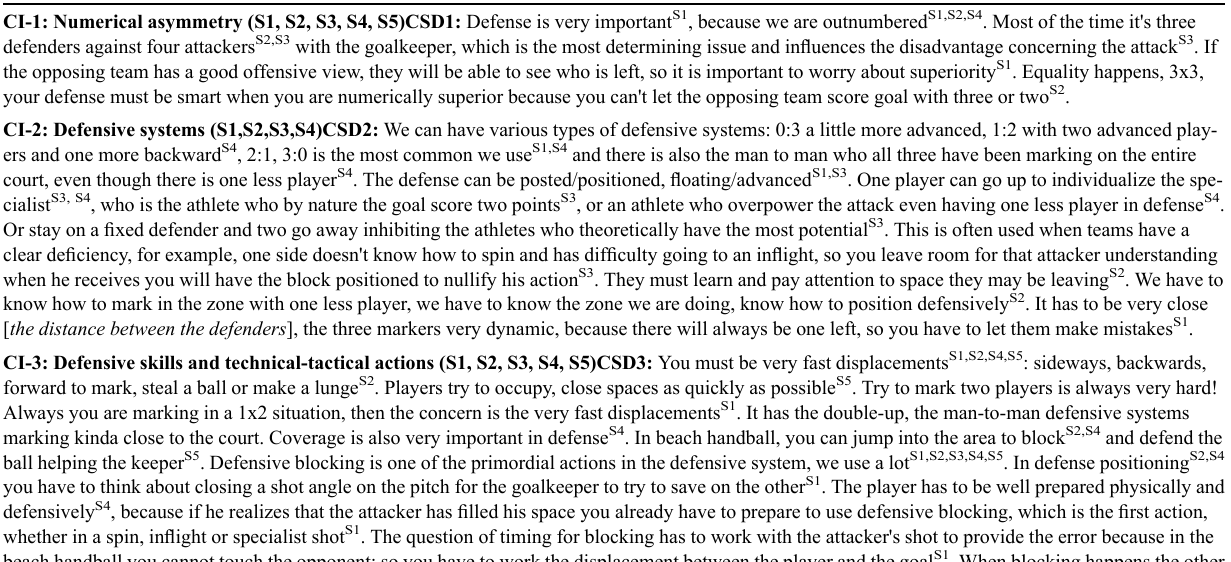
Table 1 - Central ideas (CI) and collective subject discourses (CSD) referring to the structuring of the defensive game. CI-1: Numerical asymmetry (S1, S2, S3, S4, S5)CSD1: Defense is very important S1 , because we are outnumbered S1,S2,S4 . Most of the time it's three